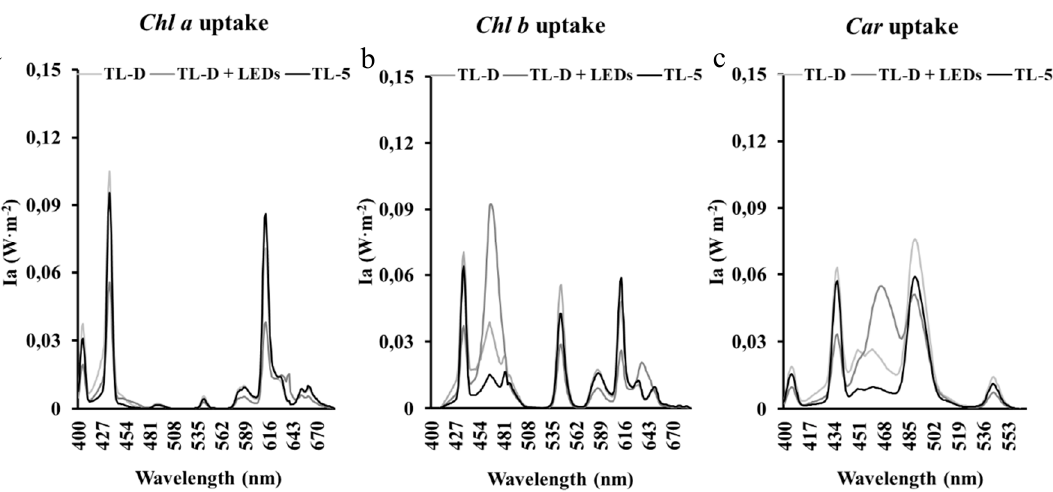
Figure 5. Theoretical irradiance energy absorbed by pigments (Ia) (chlorophyll a and b and carotenoids) in light treatments: ( a ) TL-D, ( b ) TL-D+LEDs and ( c ) TL-5.